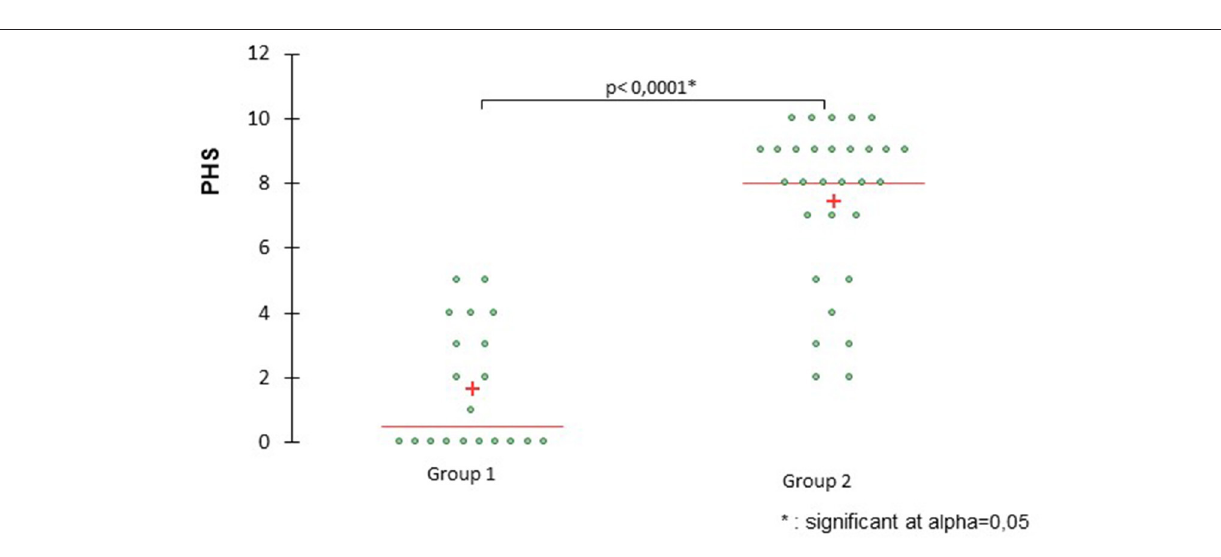
FIGURE 2 | Scatter plots comparing global scores between group G1 (control group, C1 + mild PCPH, C2) and group G2 (moderate PCPH, C3 and severe PCPH, C4). The pulmonary hypertension score (PHS) for G2 is significantly higher than for G1. The cross indicates the mean value and the horizontal line represents the median